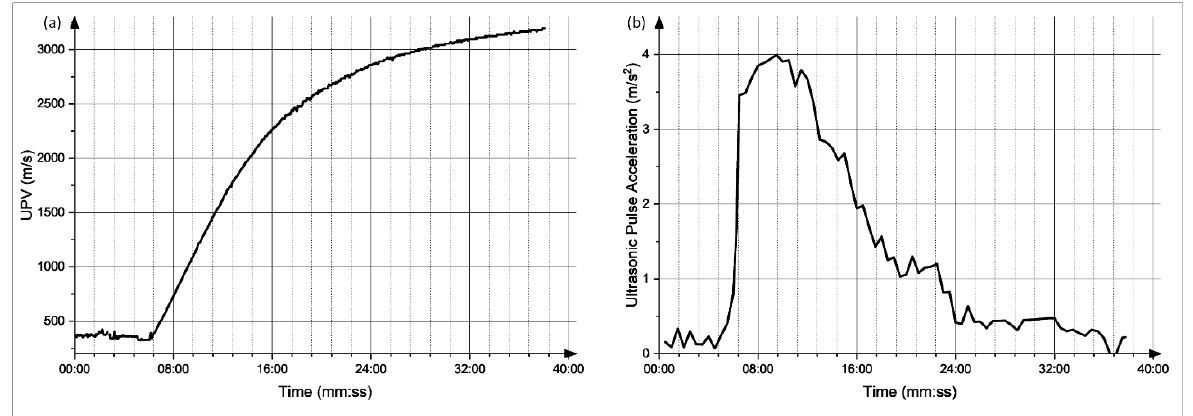
Figure 10. ( a ) Evolution of UPV with time for mix 2. ( b ) Derivative of the UPV graph.